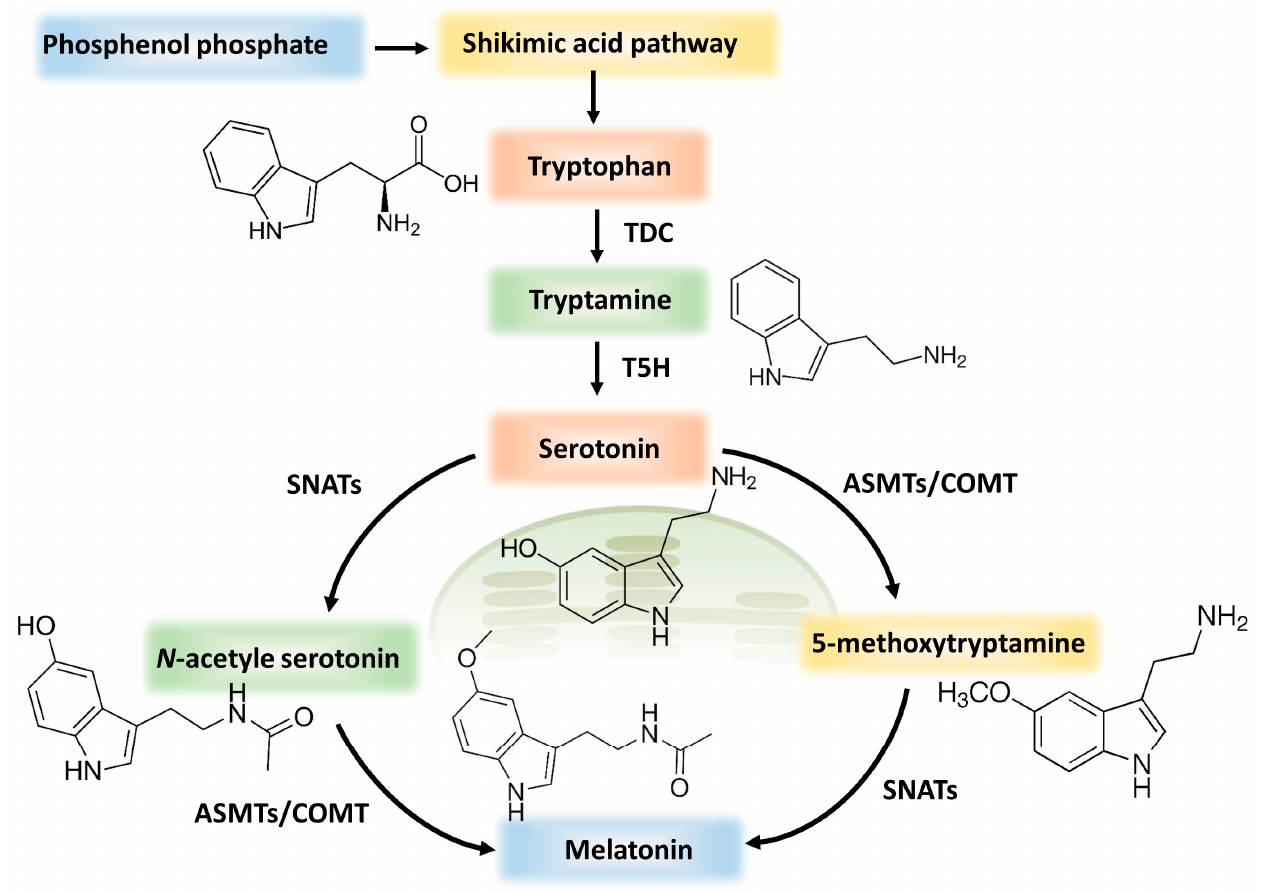
Figure 3. Melatonin biosynthetic pathway in plants.